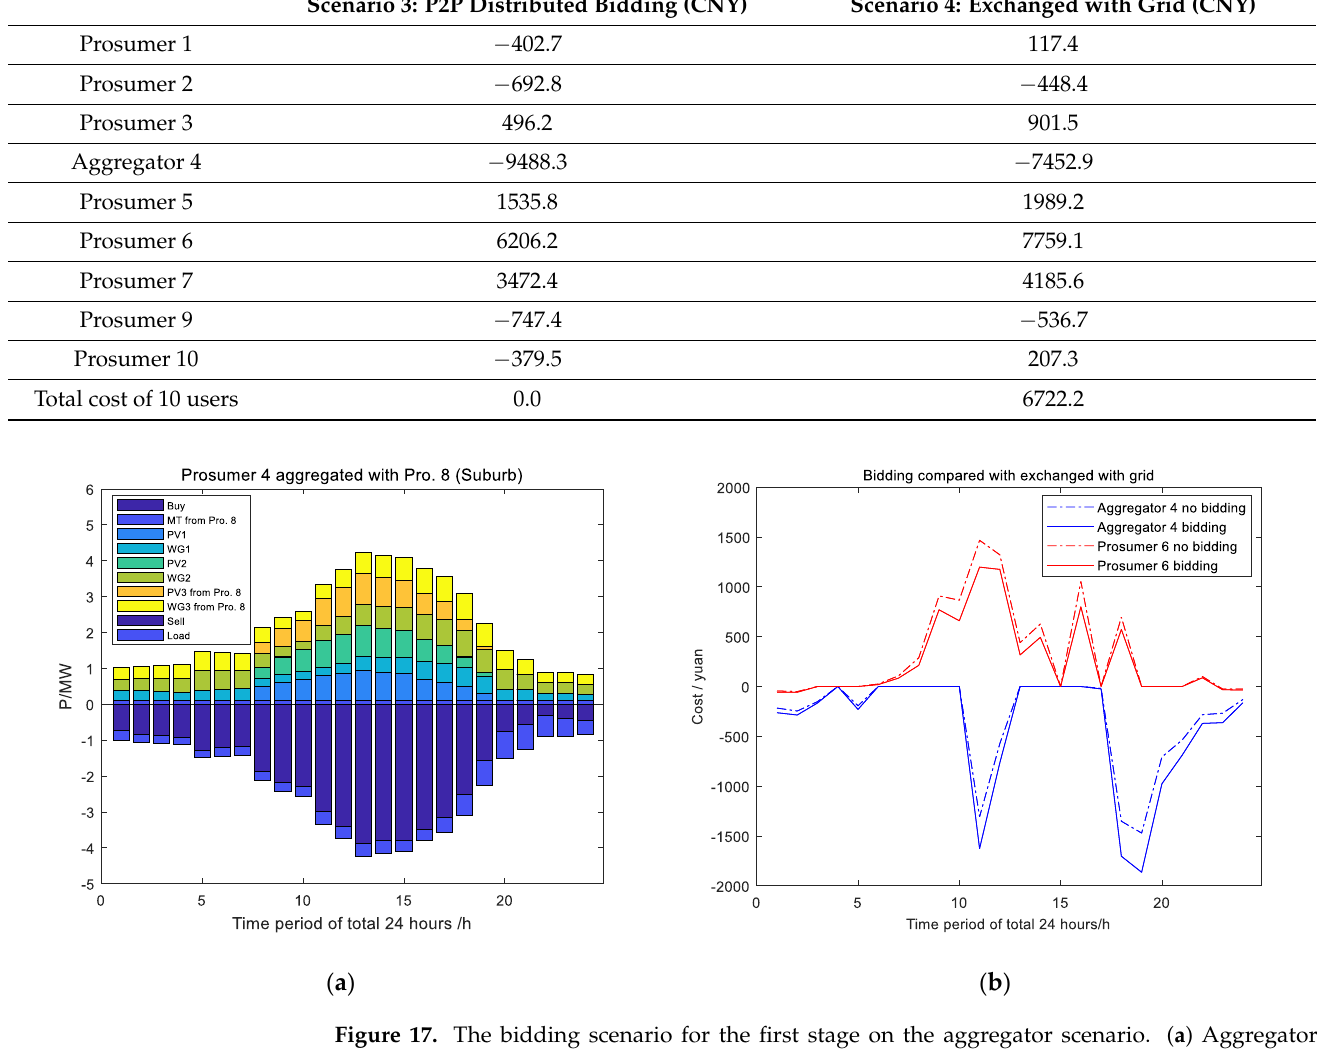
( b ) Figure 18. The bidding price comparison. ( a ) Compared with average bidding price; ( b ) Compared with average capacity price. In order to improve the competitiveness of pur e renewable energy prosumers, it’s necessary to study the quotation strategy. Although they are the only power suppliers in the evening peak-load periods, the loss of the morning peak-load will lead to profit reduc- tion. The pricing strategy is that the quotation of the renewable energy aggregator should